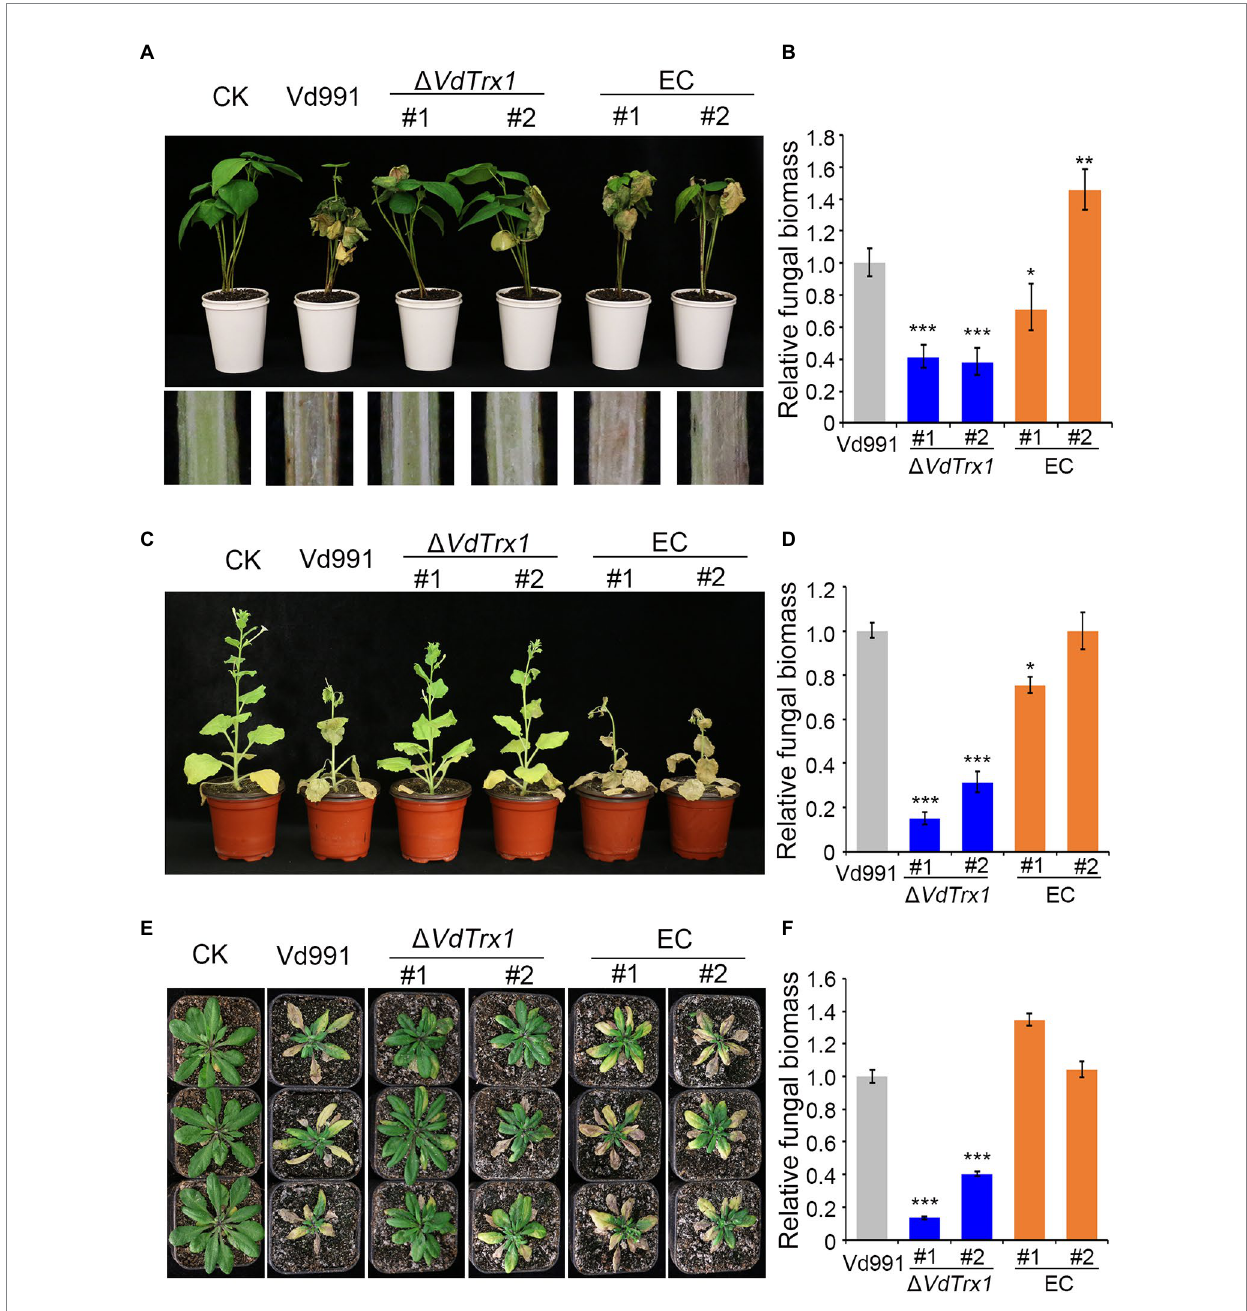
FIGURE 7 VdTrx1 is required for the full virulence of V. dahliae . (A) The disease symptoms of cotton seedlings inoculated with sterile water (CK) or the VdTrx1 deletion strains, complemented strains (EC#1 and #2) and wild-type strain (Vd991) at 21 days post-inoculation (Top). The discoloration of the inoculation shoot longitudinal sections is shown at the bottom. Phenotypes of N. benthamiana (C) and A. thaliana (E) plants inoculated with indicated strains. The fungal biomasses of each fungal strain in cotton (B) , N. benthamiana (D) and A. thaliana (F) plants were determined by qPCR. Error bars represent standard deviations ( n = 3). Asterisks *** indicate significant differences at ( p < 0.001) based on the Student’s t